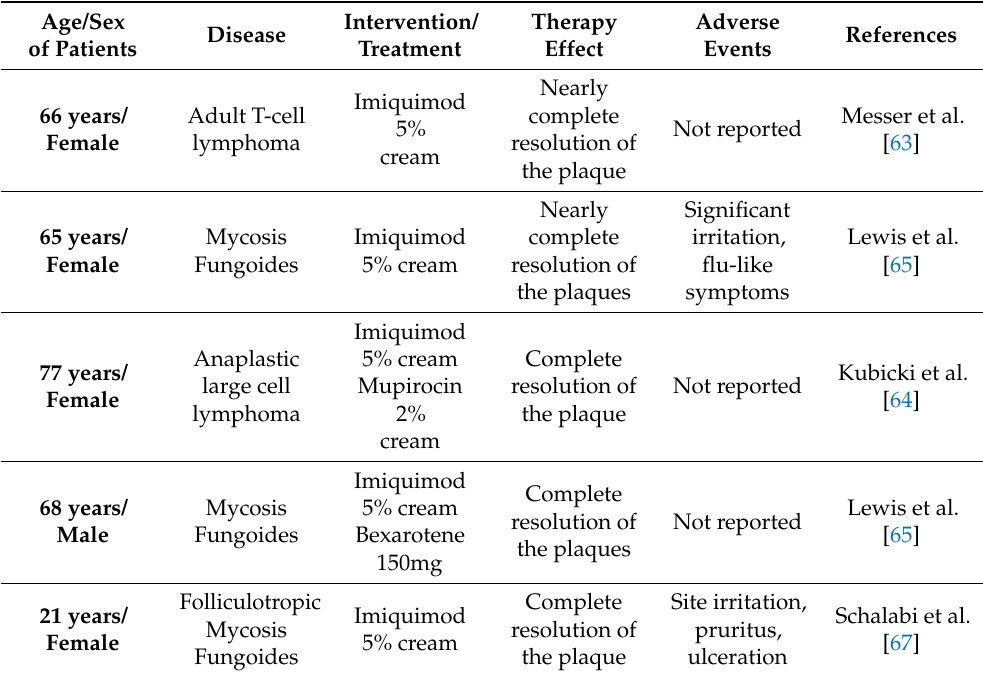
Table 1. Case series’ reported results on the use imiquimod in the treatment of cutaneous lymphoma.